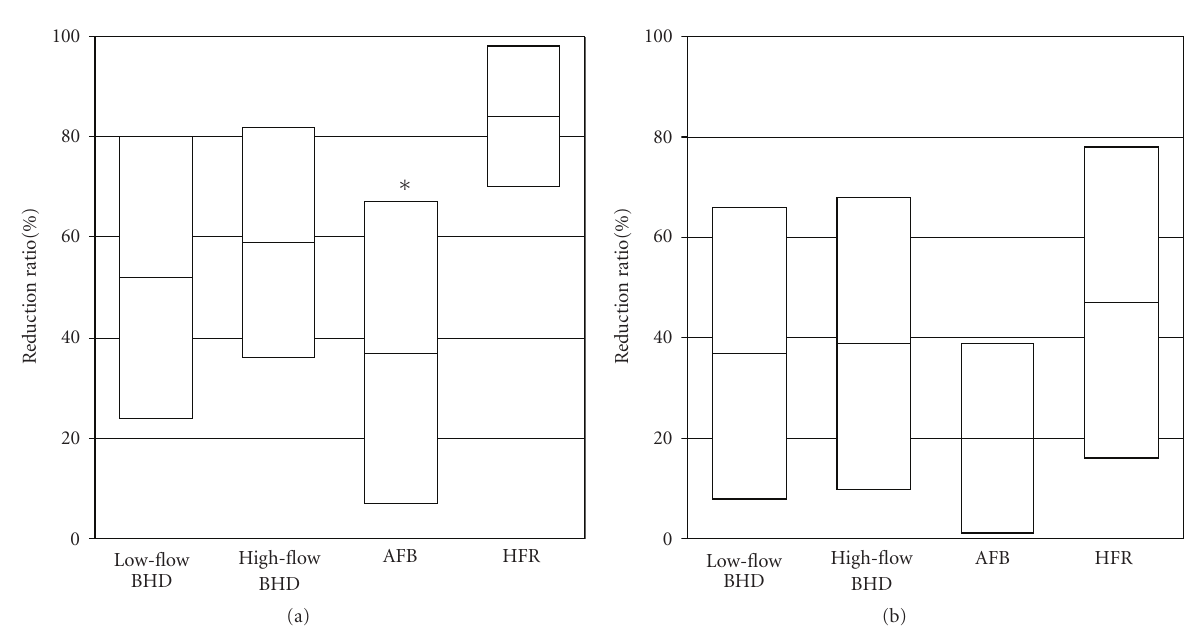
Figure 4: Reduction Ratio (%) of serum hepcidin-25 (a) and hepcidin-20 (b) by the di ff erent hemodialysis techniques. ( ∗ Statistically significant P < .